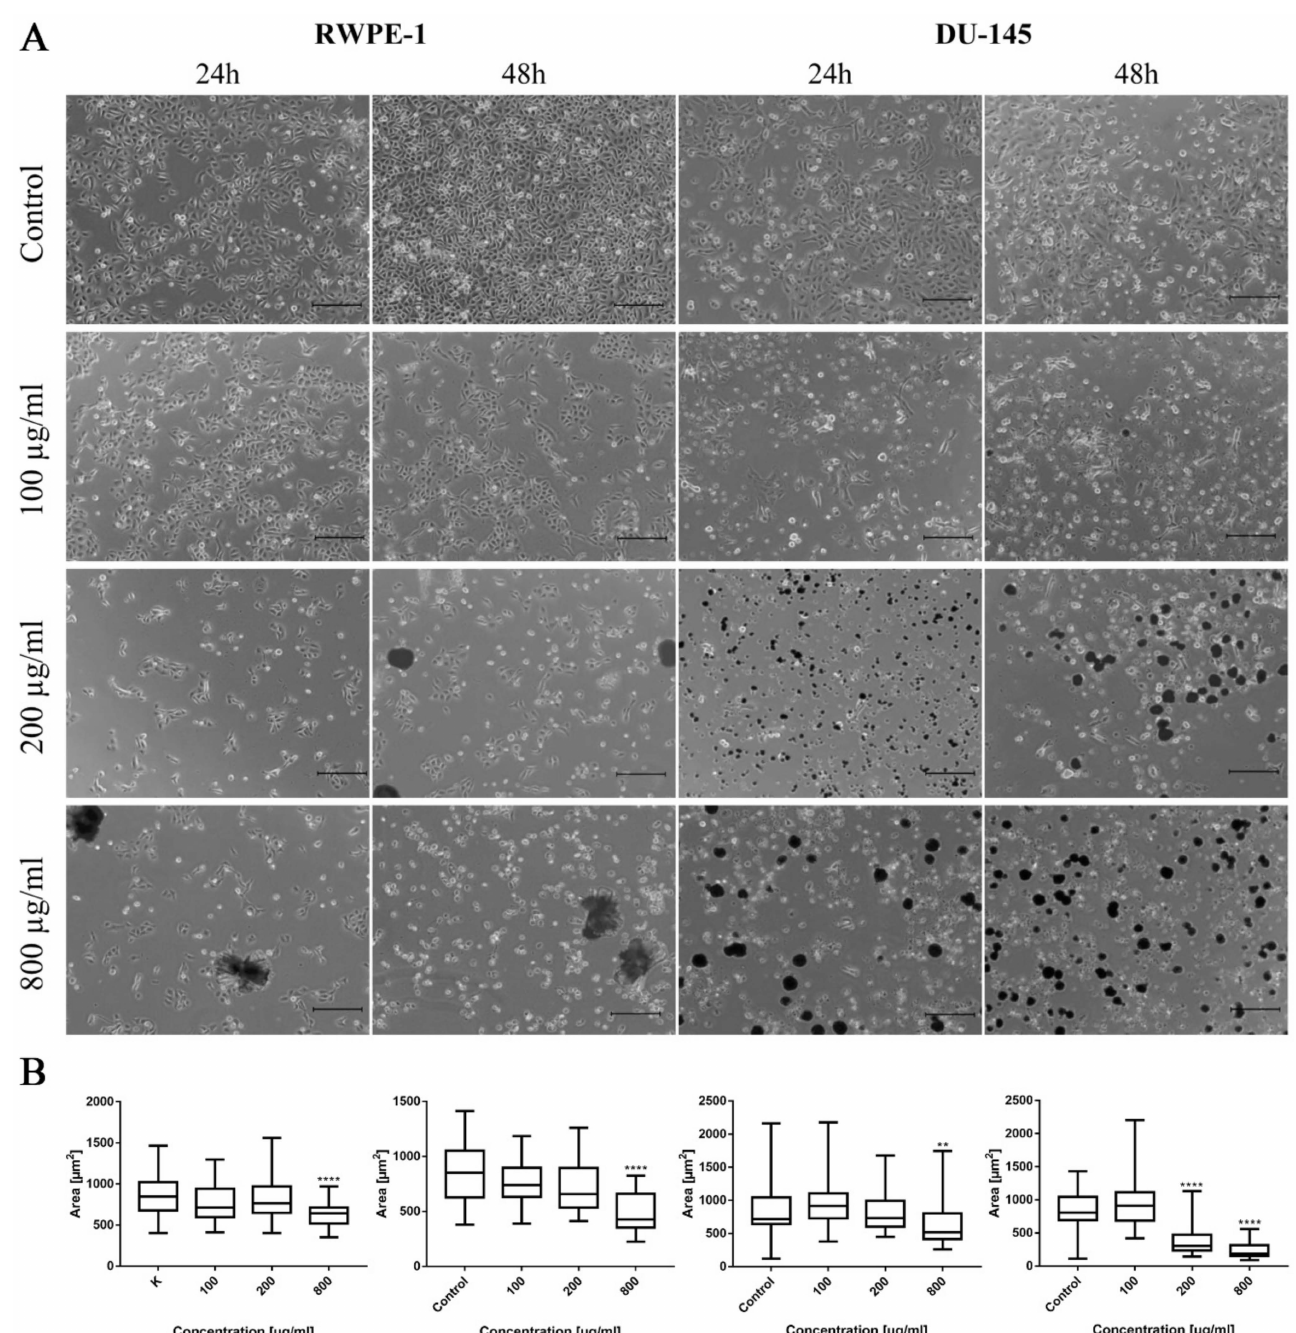
Figure 2. Prostate cell lines characteristic after ciprofloxacin treatment. ( A )—Morphology of prostate cell lines after ciprofloxacin treatment. Cell shrinkage, rounding, and detachment were visible after ciprofloxacin treatment, especially in higher concentrations. Ciprofloxacin crystal formation was visible in a concentration of 200 µ g/mL for RWPE-1 DU-145, using an inverted light microscope (bar = 200 µ m). ( B )—Morphometric analysis of cells area. DU-145—human prostate cancer; RWPE-1—non-malignant human prostate epithelium; statistically significant results compared to control were presented: **— p ≤ 0.01; ****— p ≤